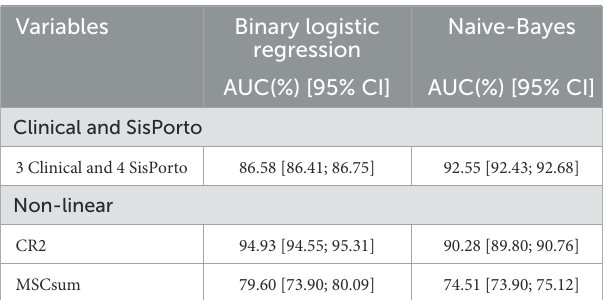
TABLE 4 The area under the receiver operating characteristic curve and respective confidence interval of 95 % obtained in the asphyxia prediction